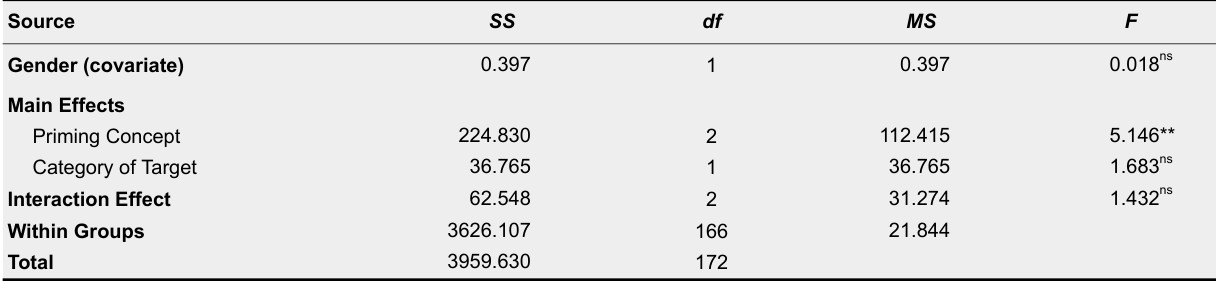
Two-Way Analysis of Covariance Summary of